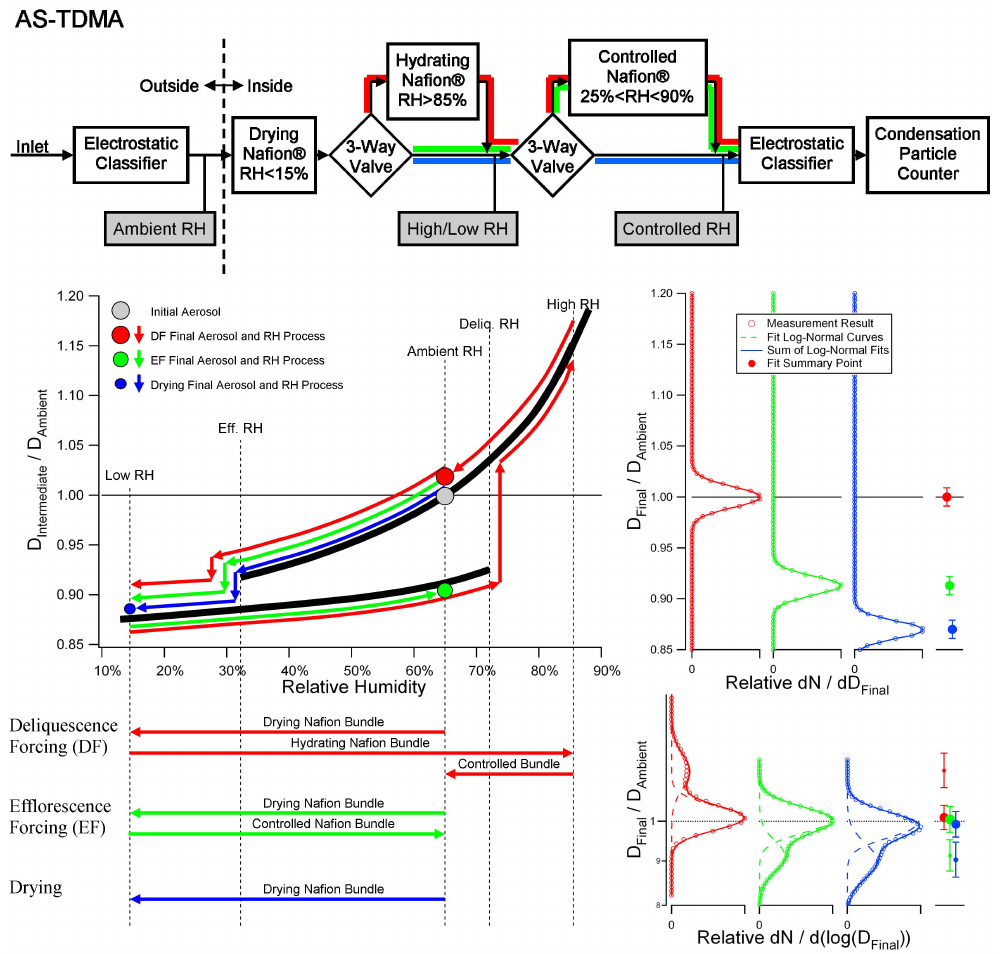
Fig. 2. AS-TDMA schematic and experimental procedure illustration. The configuration and results for the DF, EF and Drying process are shown in red, green and blue, respectively. The grey elements of the schematic represent RH Probes. The procedure illustration depicts AS-TDMA operation on a hypothetical aerosol found in a more hydrated state at 65% RH. Its hydration characteristics are illustrated in the upper-left chart. The arrows in the upper left and lower left depict the manipulations of RH achieved in the Nafion tube bundles. The resultant size distributions produced by the process measurements are shown in upper-right corner. In the lower-right, an example taken from the winter study period is displayed. Shown along the right edge is a compact convention for displaying the